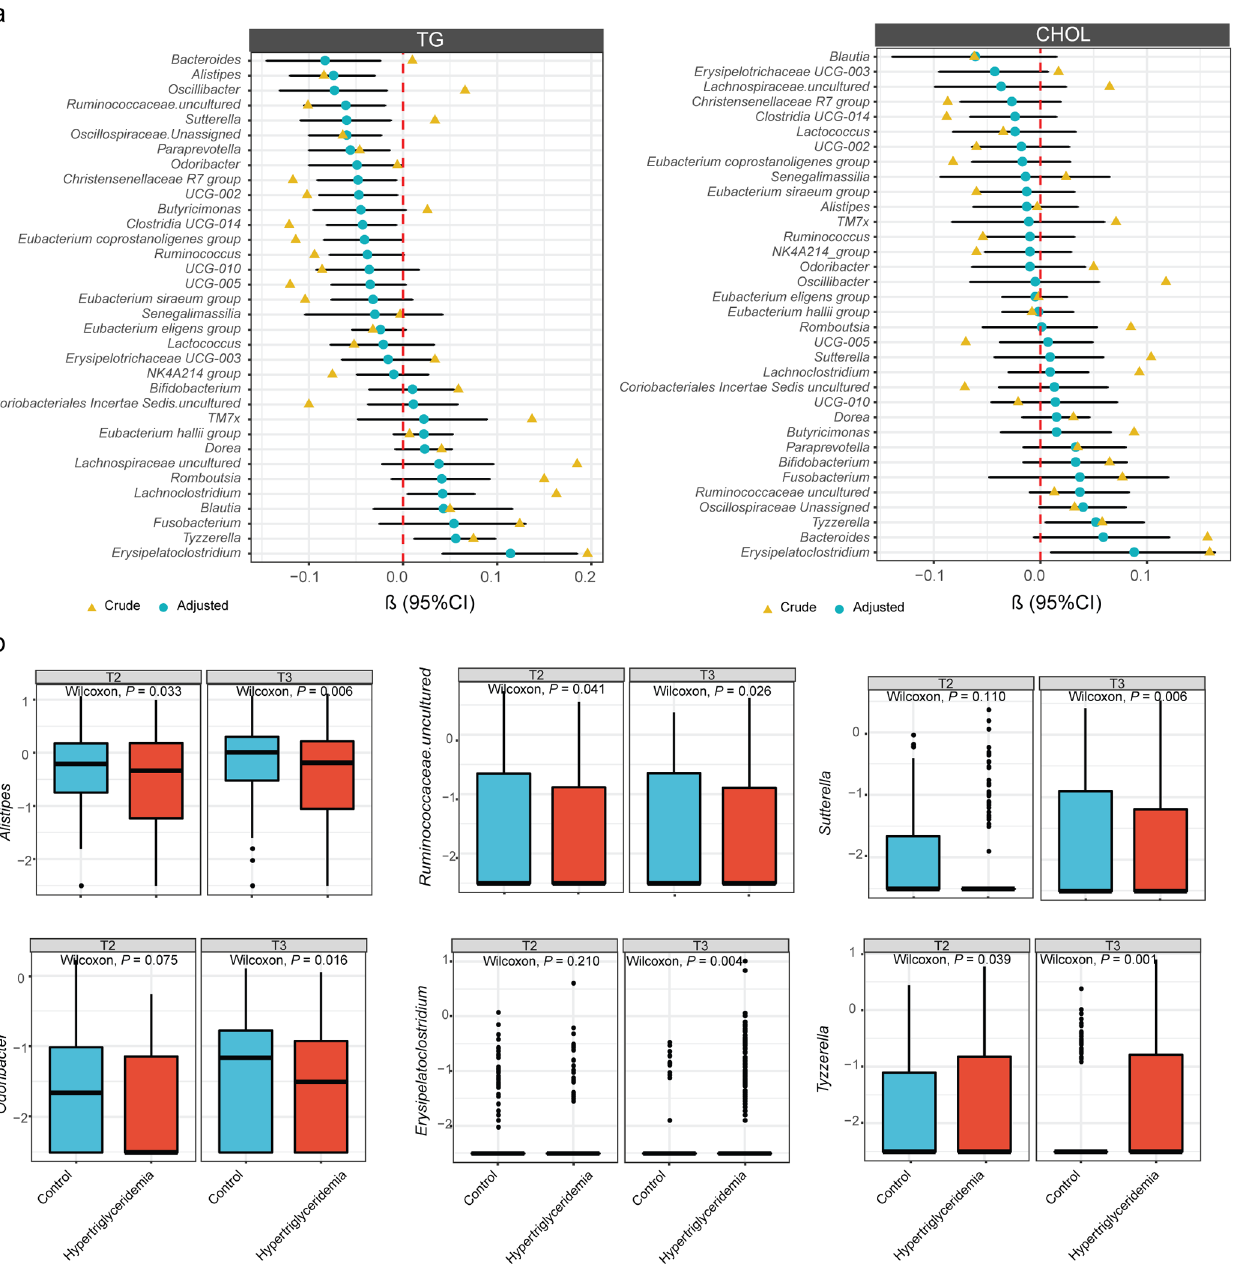
Fig. 4 Association between the gut microbiota and dyslipidemia. a Genera associated with TG and CHOL levels with and without covariate adjustment. Covariates included in all models were maternal age, prepregnancy BMI, parity, and sampling time. Genera shown had covariate- adjusted FDR < 0.2 in one of the results identi fi ed by different periods. Symbols (yellow and blue) showed the beta coef fi cient, and error bars represented standard error. b Differential genera between hypertriglyceridemia and non-hypertriglyceridemia groups. The center line denoted the median. The boxes covered the 25th and 75th percentiles, and the whiskers extended to the most extreme data point, which was no more than 1.5 times the length of the box away from the box. Points outside the whiskers represented outlier samples. P values in the plots showed P obtained from the Wilcoxon rank-sum